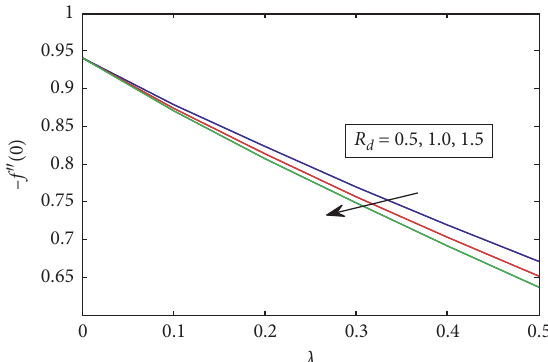
Figure 20: Local skin friction for different values of R